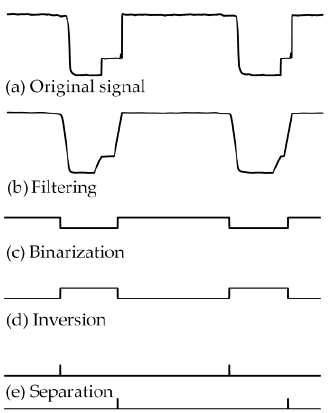
Figure 3. A piece of signal during pre-processing. ( a ) Original signal; ( b ) Signal filtering processing; ( c ) Binarization processing; ( d ) Inversion processing; ( e ) Separation processing.